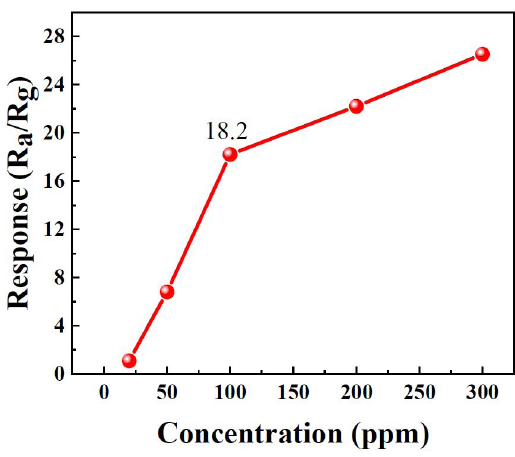
gas sensor under different ethanol 3